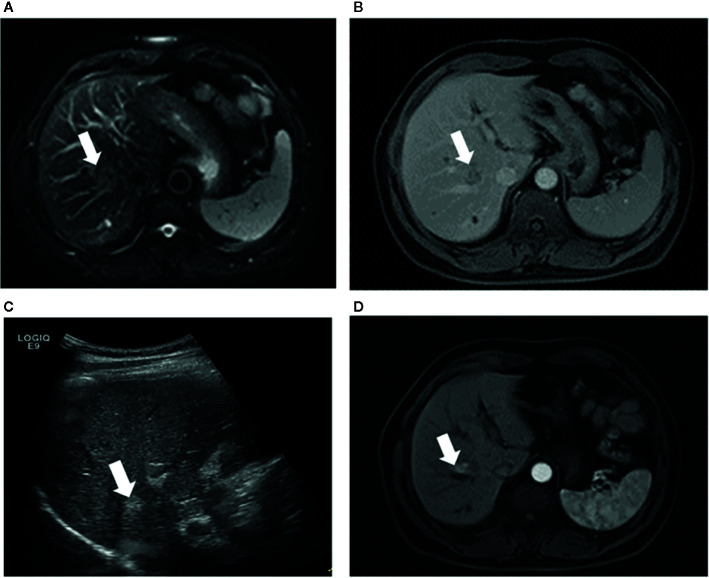
Images in a 53-year-old-man who underwent RFA for perihepatic CLM. (A) Axial MRI T2-weighted images shows a 2.6-cm lesion of high signal intensity (arrow) in segment VIII before RFA. The index tumor abuts the hepatic vein. (B) Axial enhanced MRI image shows that the lesion (arrow) washes out in equilibrium phase; (C) US image before RFA shows that the index tumor (arrow) is in contact with the hepatic vein. The patient underwent RFA, obtained technical effectiveness 1 month after RFA. (D) Axial enhanced MRI image showed local tumor progression around the ablation zone 6 month after RFA. CLM, colorectal liver metastases; US, ultrasound; RFA, radiofrequency ablation.